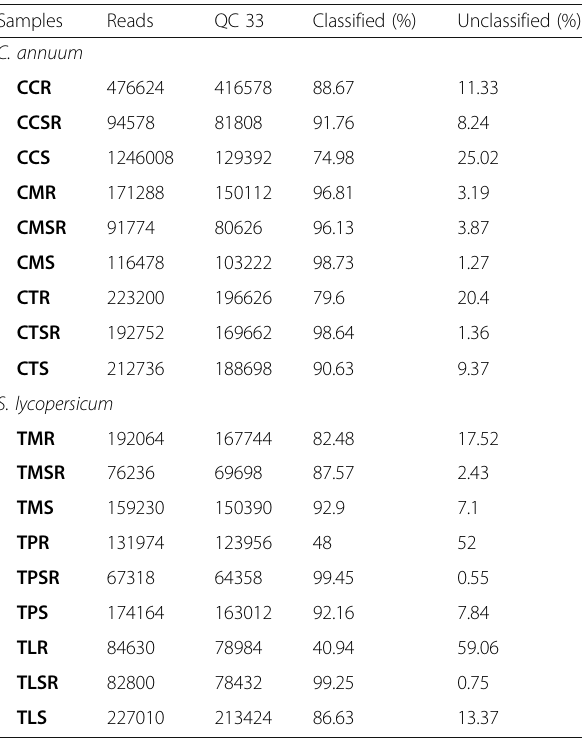
Table 1 Sequencing reads generated, filtered for the quality control ( Q ≥ 33), and assembled with a minimum identity of 98%, for comparison against the GenBank